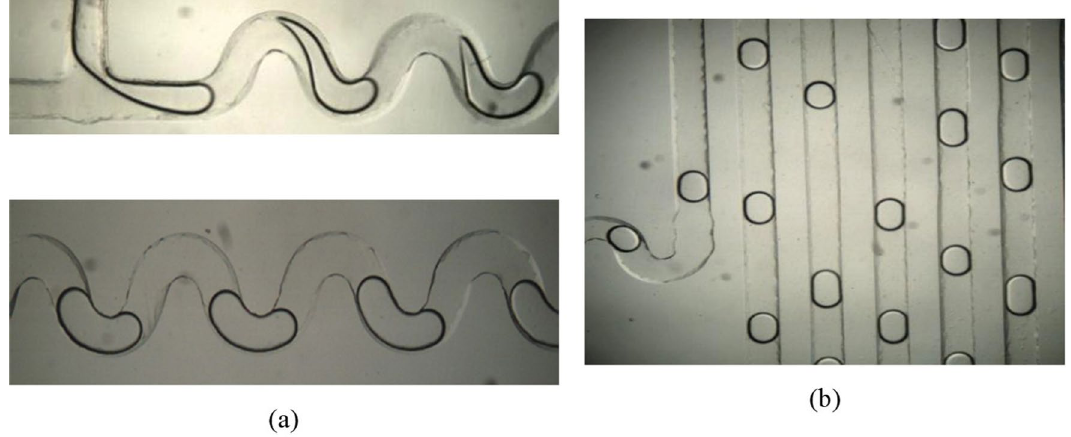
Figure 4. ( a ) Droplet generation and movement in the serpentine channel for a flow rate of 10 µl/min, ( b ) Droplet movement in the heating zone wherein droplets of uniform size can be seen.